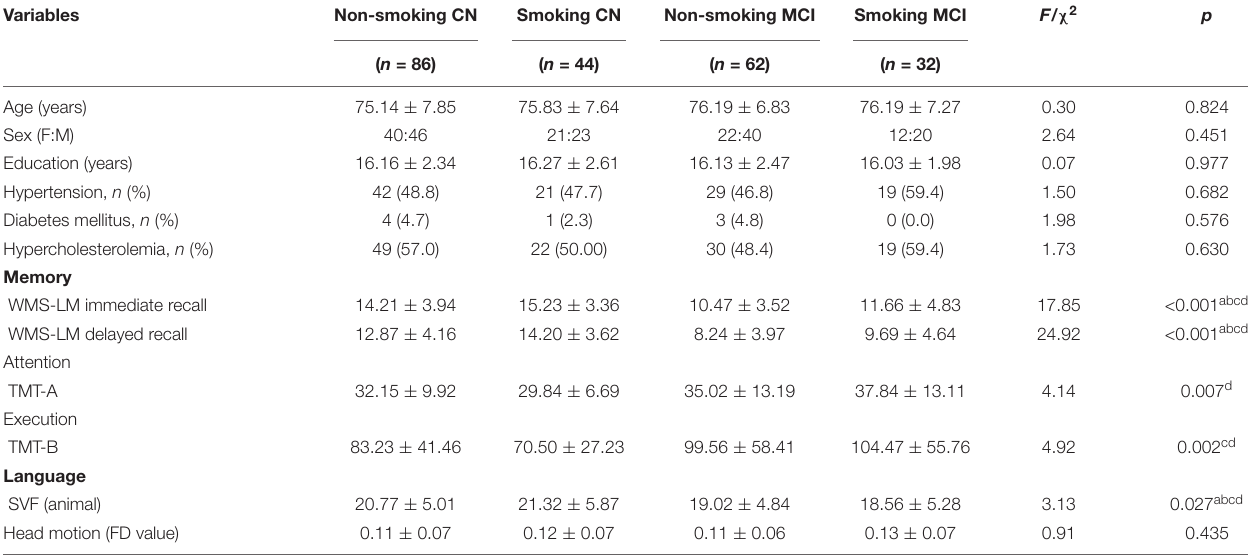
TABLE 1 | The demographics and neuropsychological data.